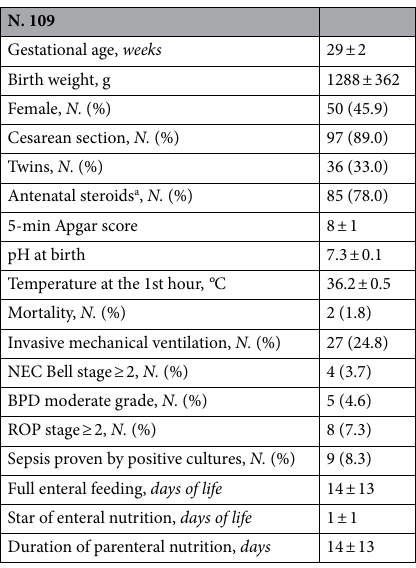
Table 1. Clinical characteristics of study population. NEC necrotizing enterocolitis bell stage ≥ 2, BPD bronchopulmonary dysplasia, ROP retinopathy of prematurity. Data were expressed as mean ± standard deviation, when not specified. a Intramuscular steroids cycle in two doses of 12 mg over a 24-h period.